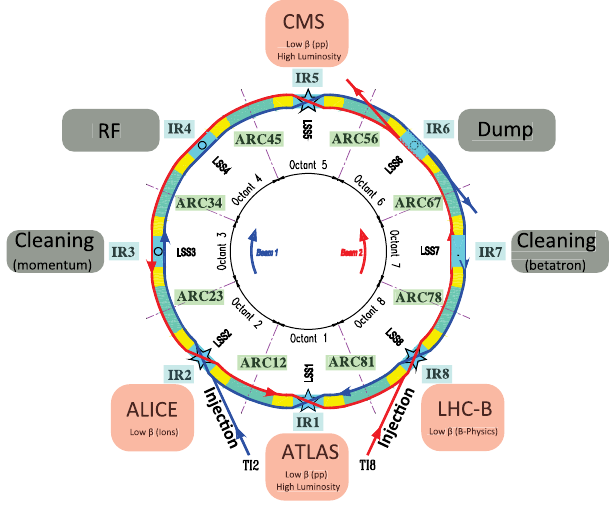
FIG. 1. Schematic layout of the LHC